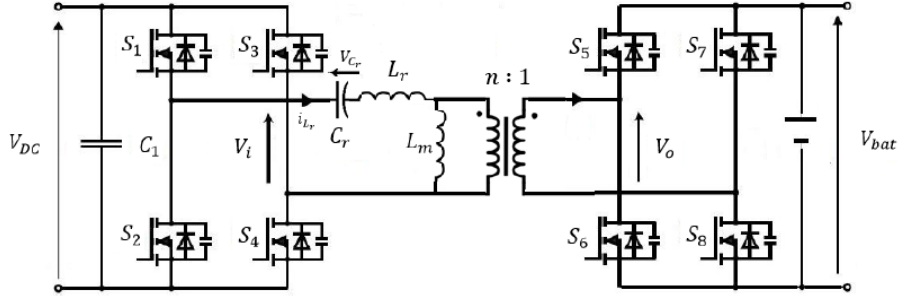
Figure 2. DC-DC LLC converter